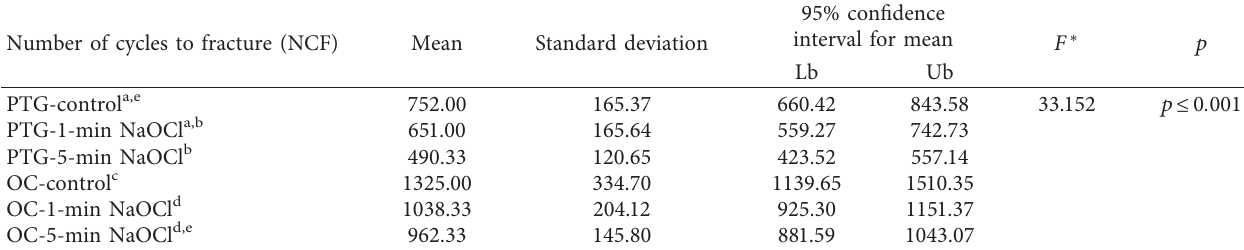
Table 1: Comparison of mean number of cycles to fracture (NCF) with post hoc Bonferroni comparisons. Number of cycles to fracture